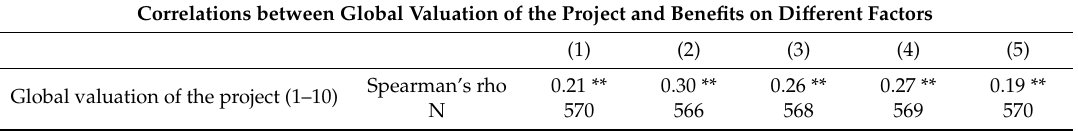
Table 15. Correlations between global valuation of the project and benefits on di ff erent